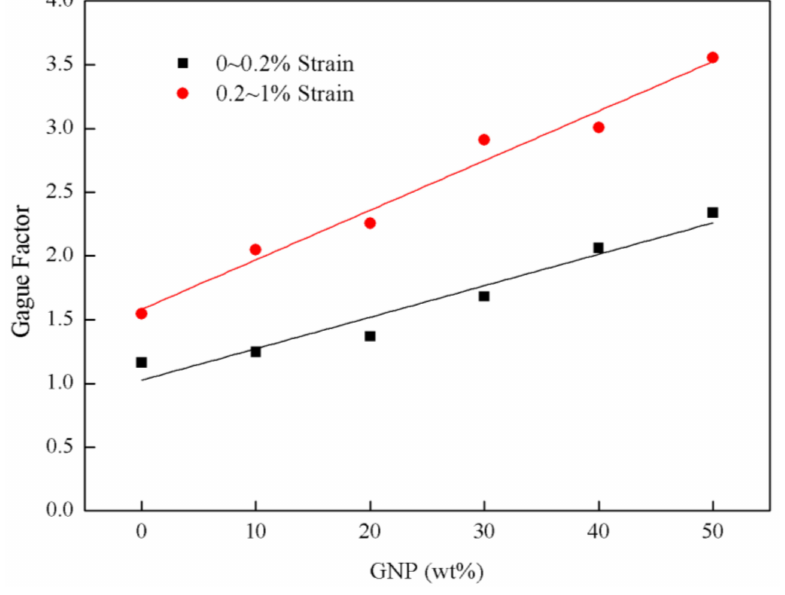
Figure 8. Gauge factor for different strain